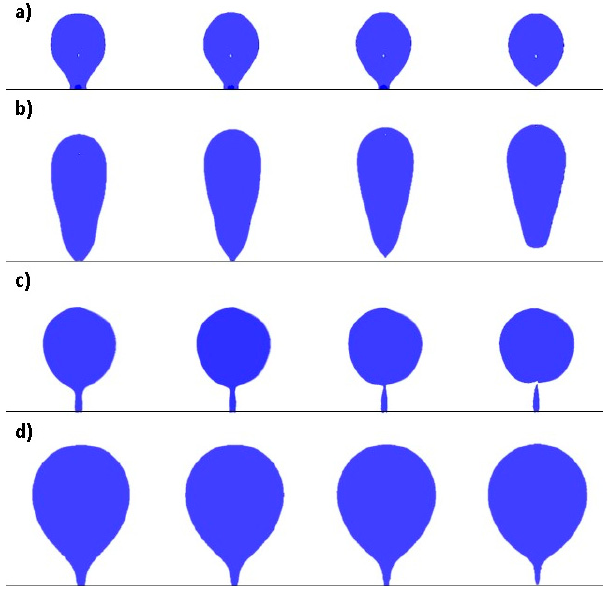
Figure 6. Changing droplet shape at time intervals of 30 µs, 44 µs, 115 µs, and 163 µs from initial boundary contact to rebound detachment for diameters of ( a ) 30 µm, ( b ) 49 µm, ( c ) 75 µm, and ( d ) 100 µm.